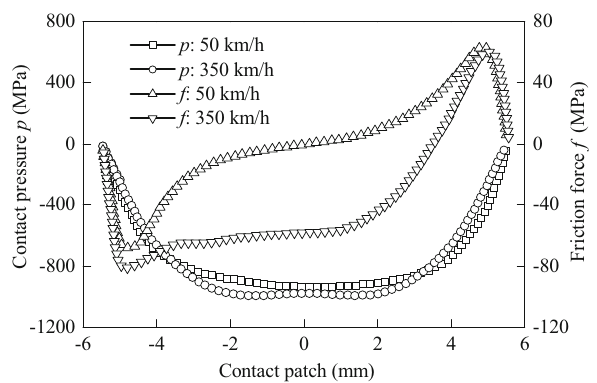
Fig. 4 Distribution of contact and friction forces between wheel and rail